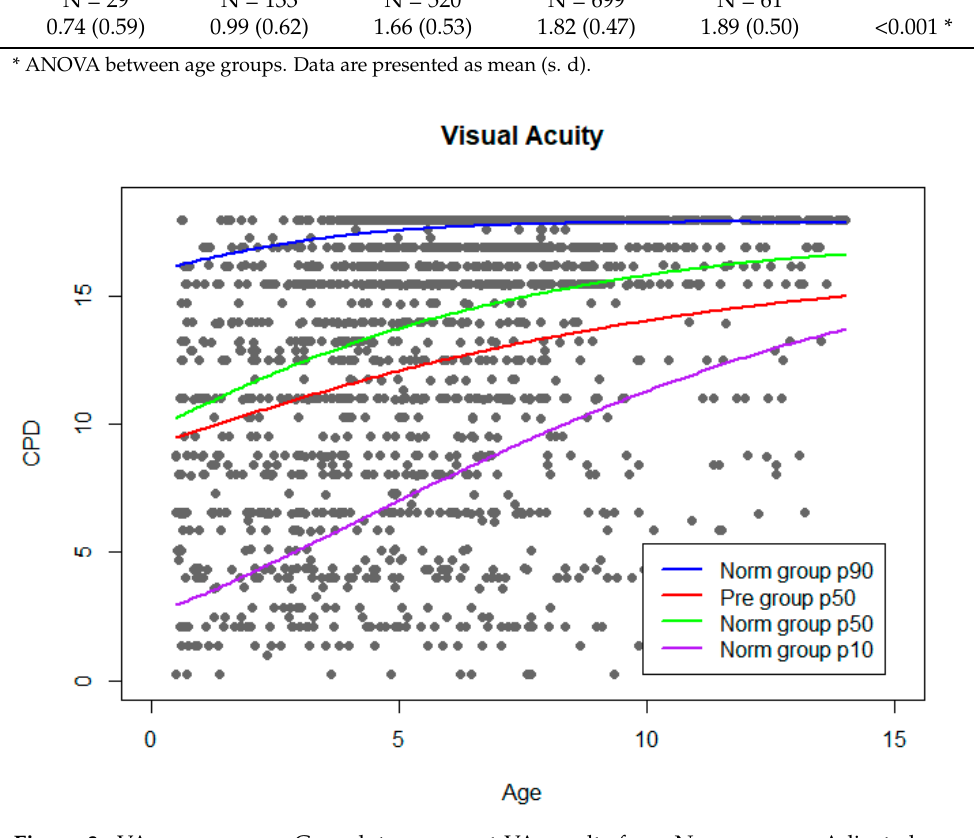
Figure 3. VA norm curve. Grey dots represent VA results from Norm group. Adjusted normal percentiles (10, 50, and 90) are shown as colour lines. Percentile 50 of Pre group was plotted on the graph.